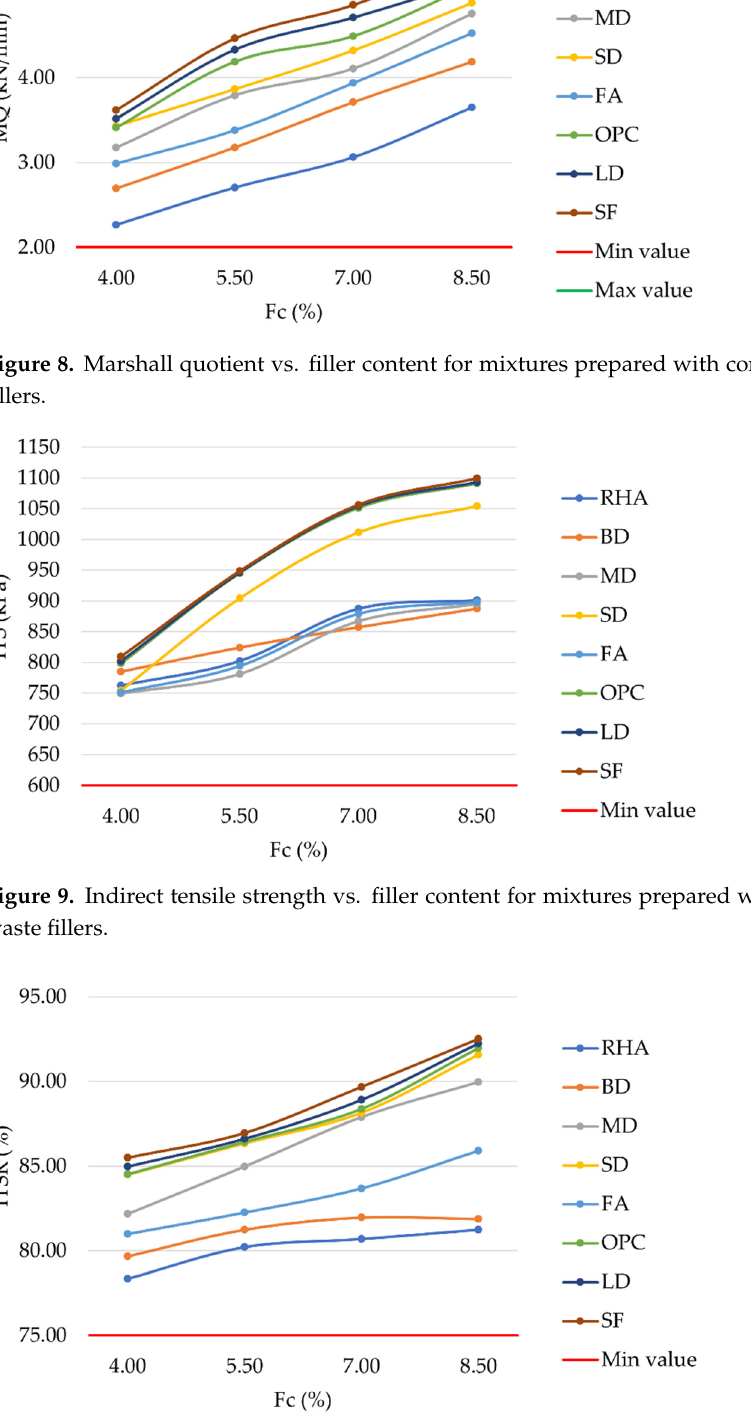
Figure 8. Marshall quotient vs. filler content for mixtures prepared with conventional and waste fillers.